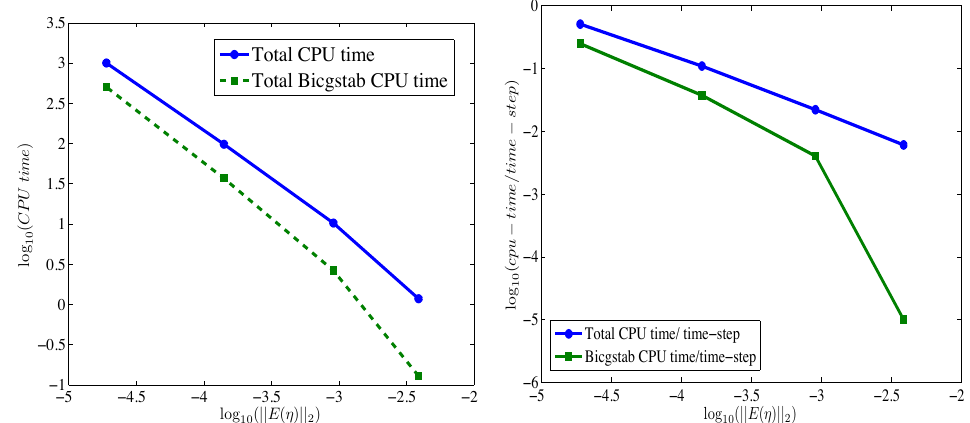
Figure 13. CPU times as a function of the free surface error measured in the L 2 norm.